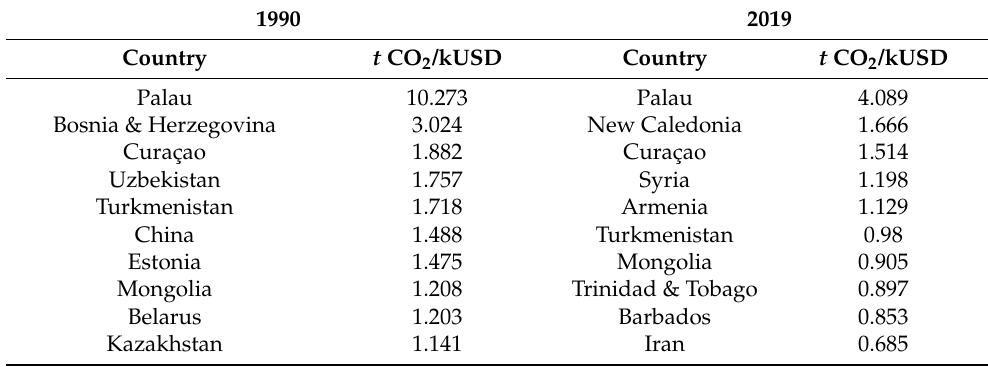
Table 6. Ten countries with the worst values of emissions per kUSD in 1990 and 2019. Own elaboration. 1990 2019 Country t CO 2 /kUSD Country t CO 2